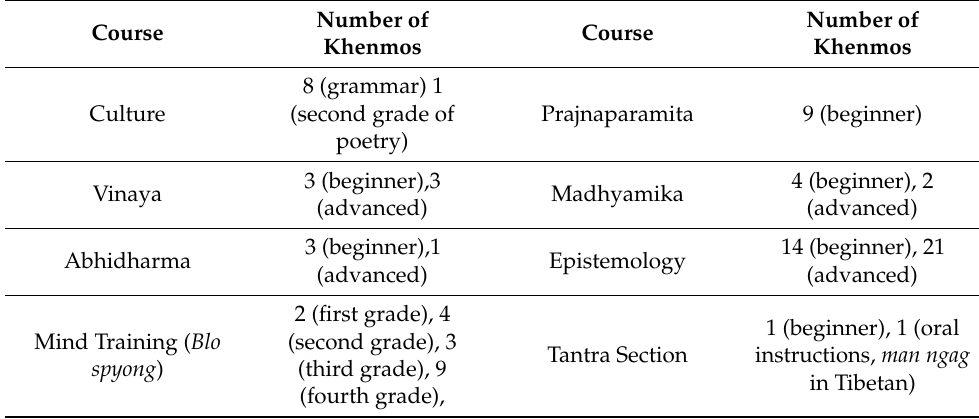
Table 8. The numbers of Khenmos who taught courses in 2018 67 .